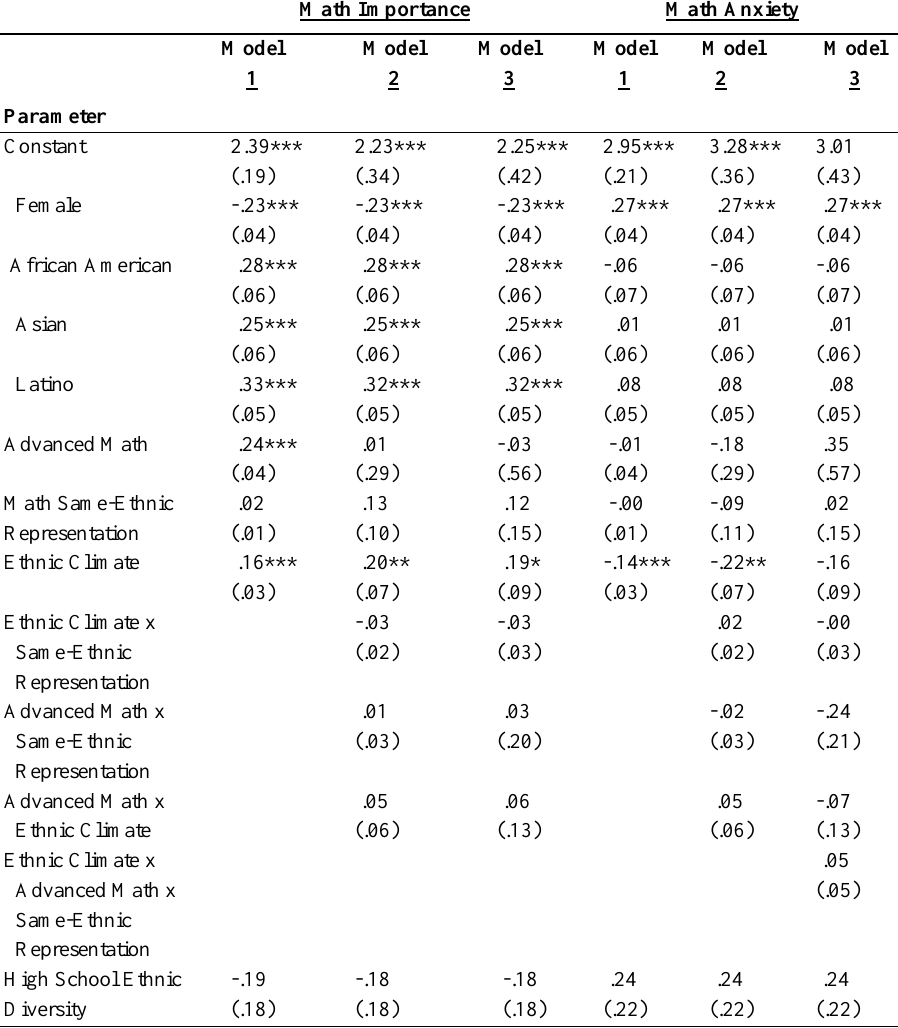
Hierarchical linear model results for math importance and math